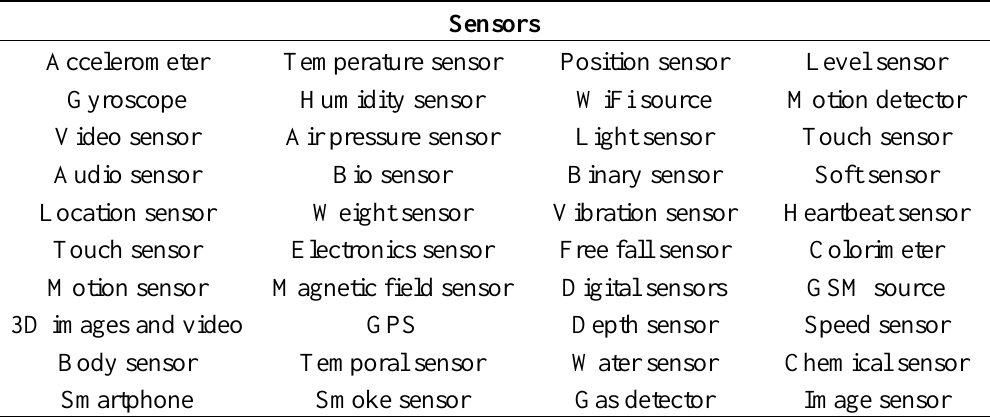
Table 1. A list of sensor technologies used for context